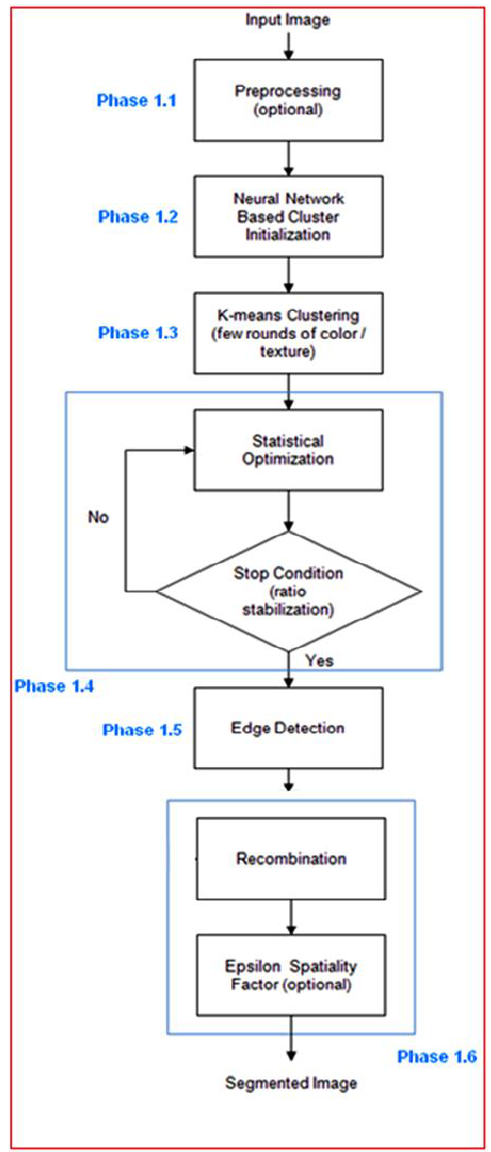
Figure 5. K-means-based hybrid segmentation design.